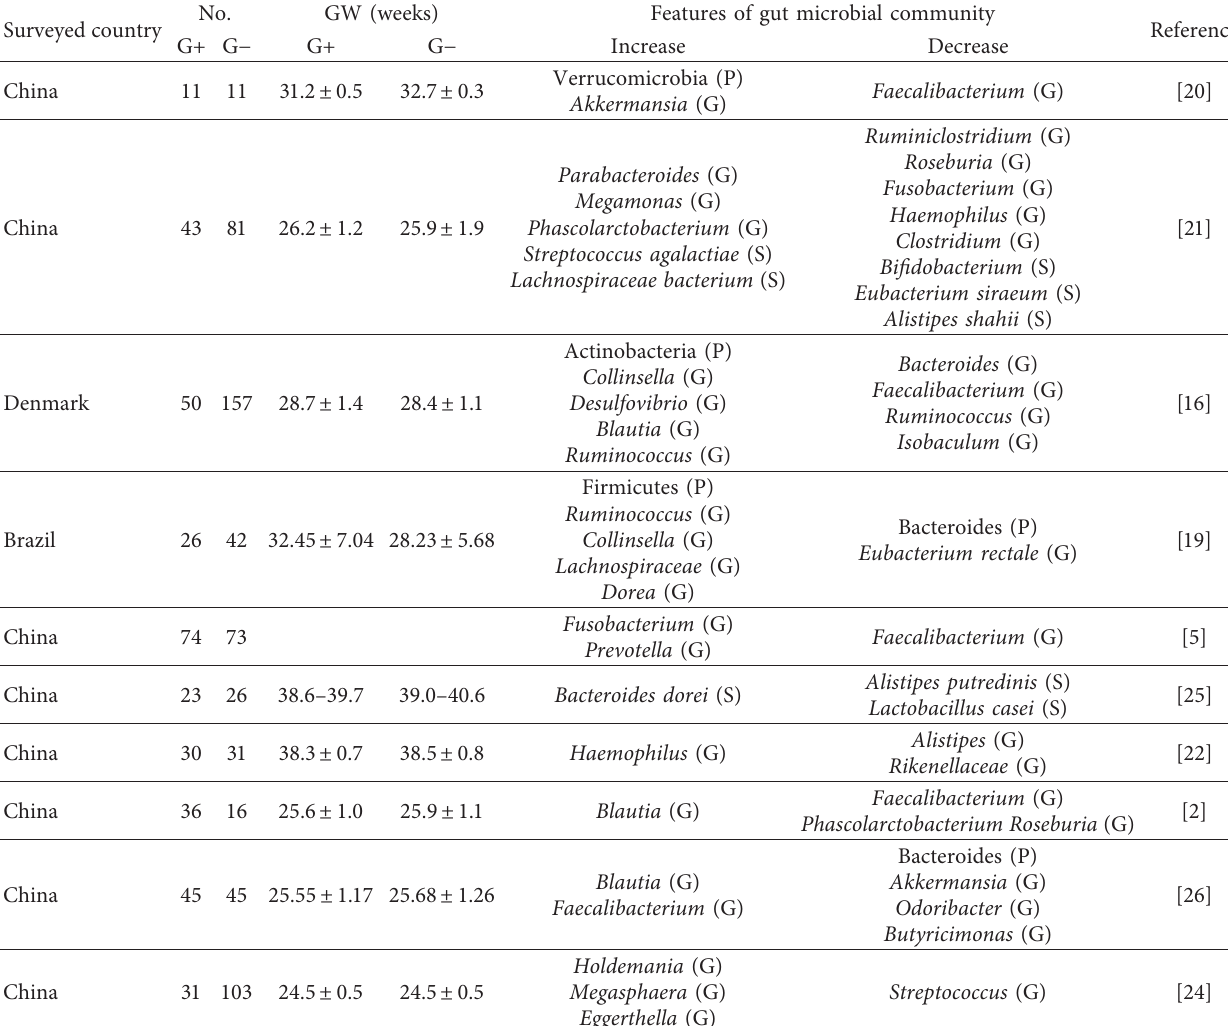
Table 1: Comparison of changes in the gut microbiota between GDM women and non-GDM women. Surveyed